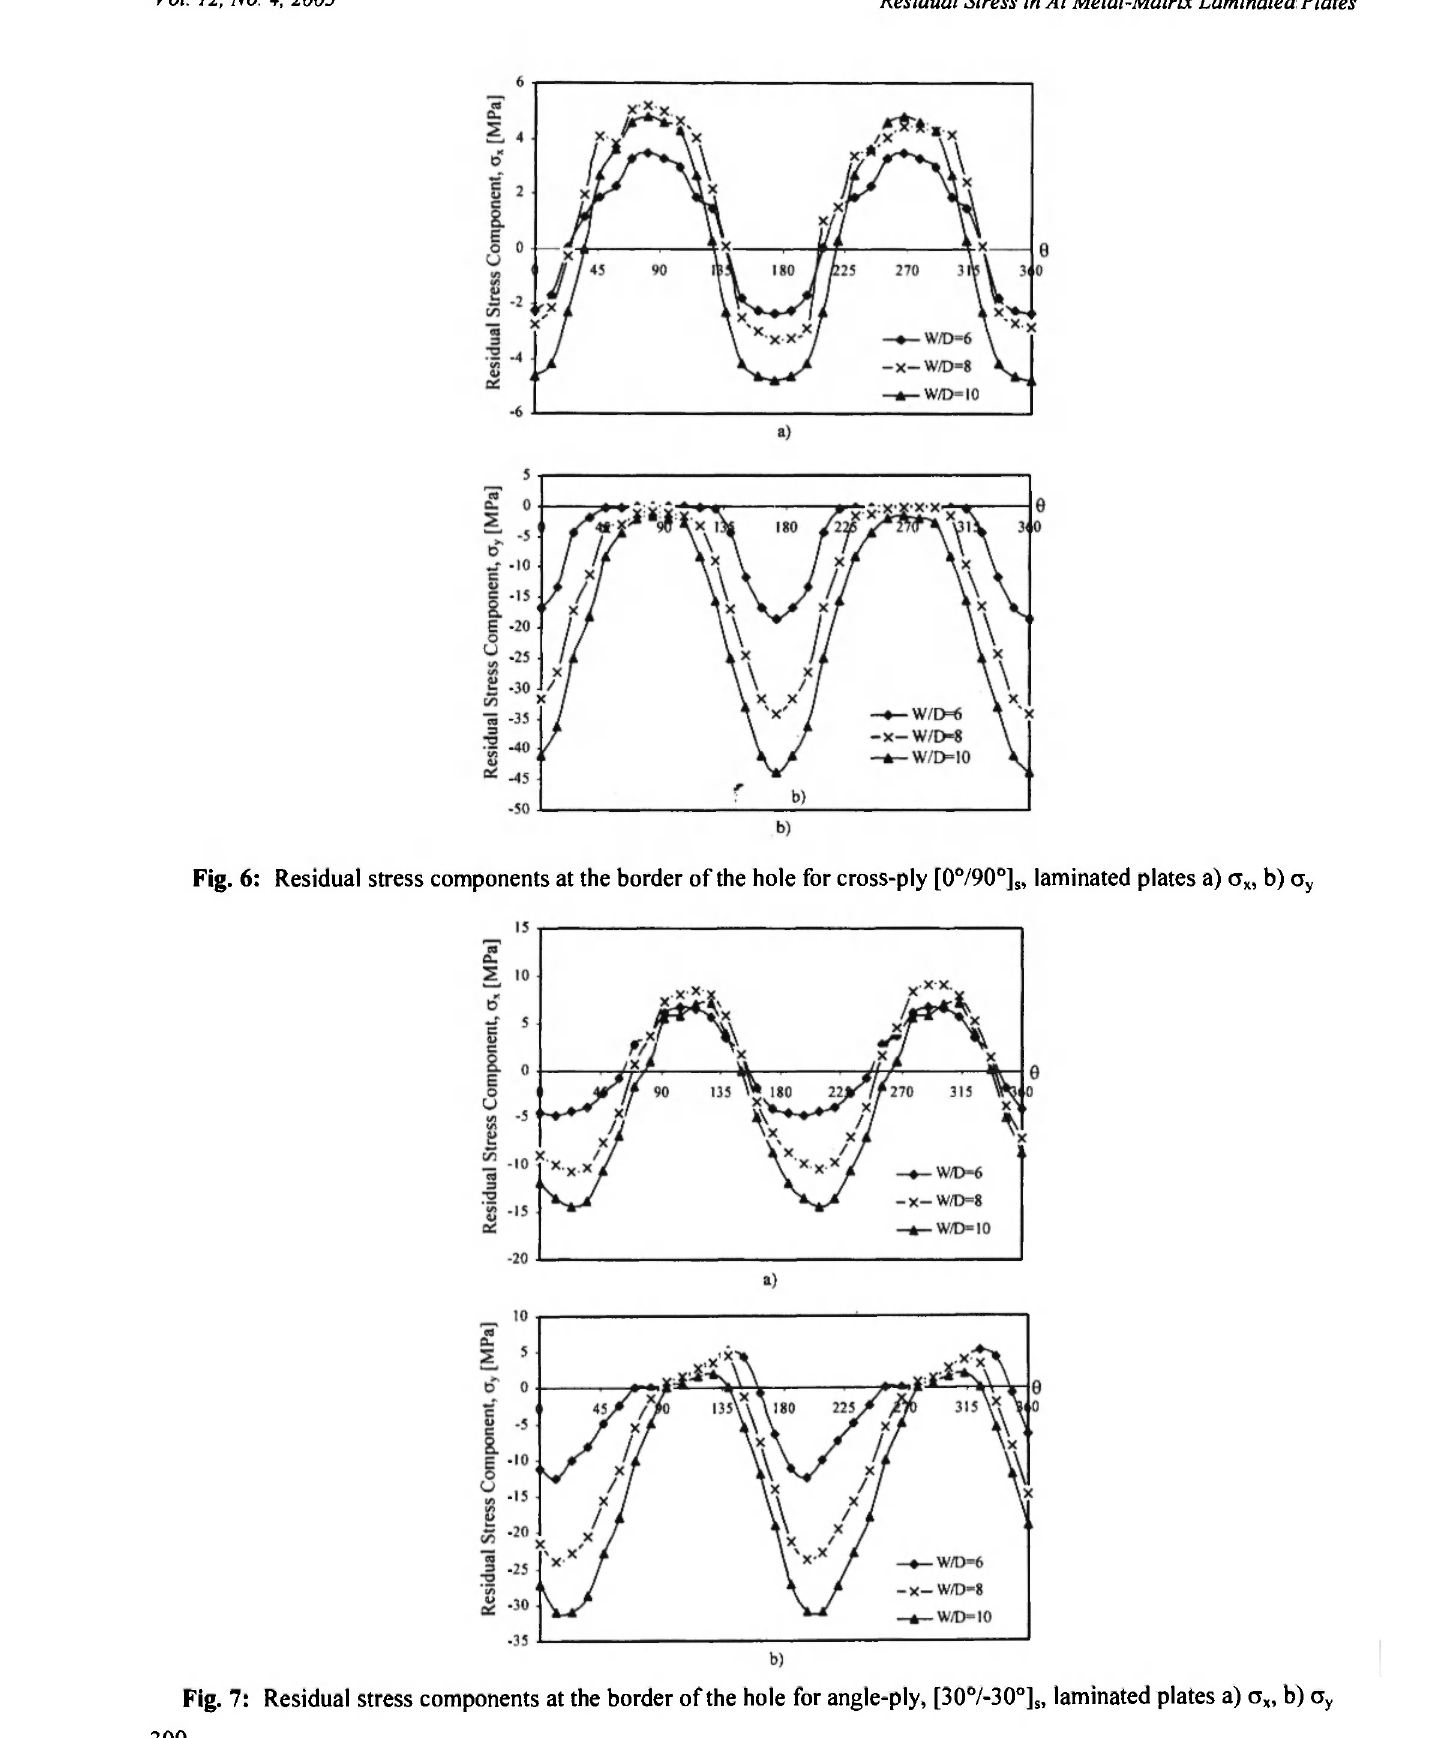
Fig. 7: Residual stress components at the border of the hole for angle-ply, [30°/-30°] s , laminated plates a) σ„, b) o y